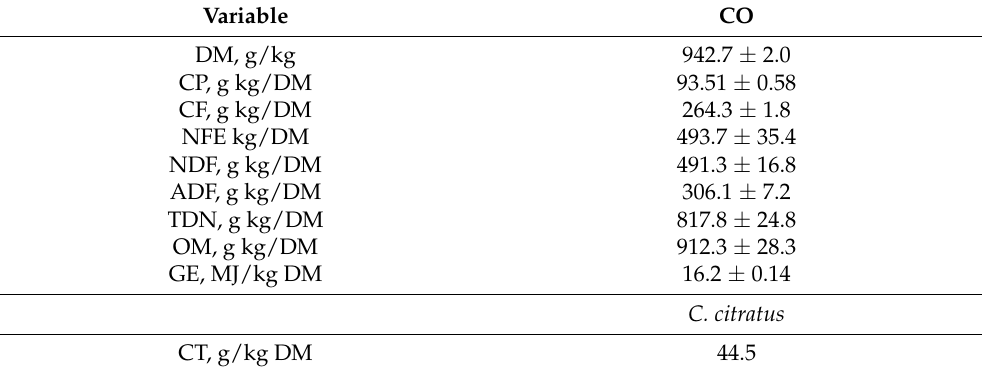
Table 1. Chemical composition of the control diet (CO) and content of the condensed tannins of the Cymbopogon citratus used in the